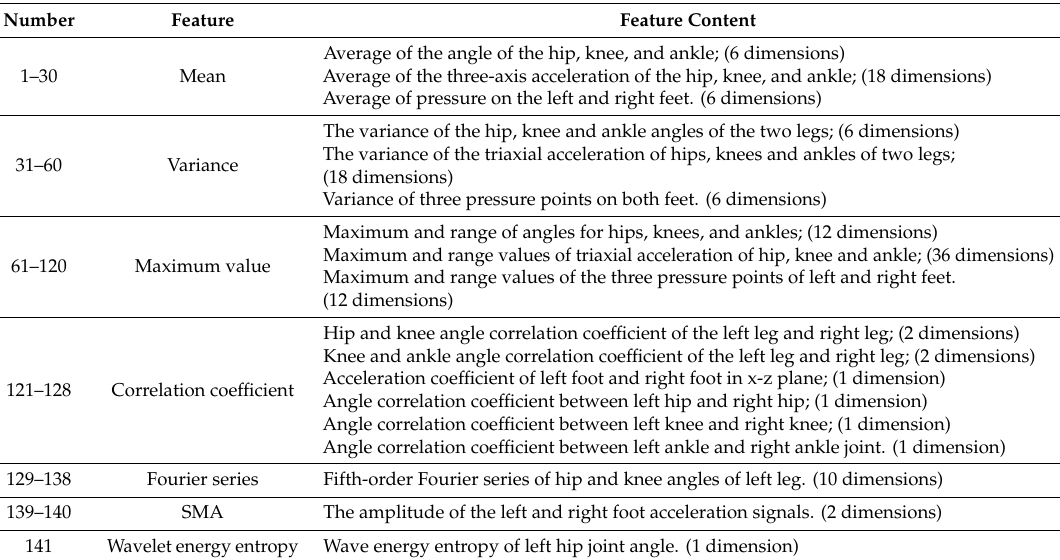
Table 2. 141-dimensional feature name and serial